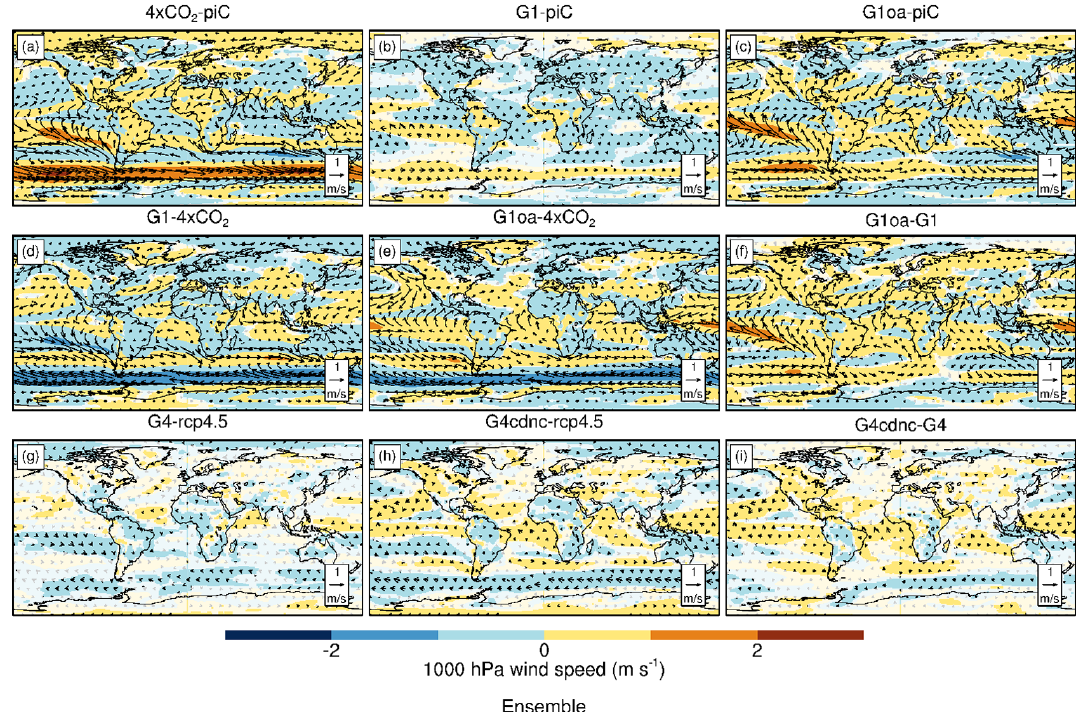
Figure 4. Spatial distribution of six ESMs and ensemble mean 1000hPa wind speed and wind direction (arrows) changes under different scenarios (11–50years). Blue colors indicate decreased wind speed; the length of arrow in each panel’s bottom right represents speeds of 1ms − 1 . Translucent white overlay indicates regions where differences are not significant at the 95% level according to the Wilcoxon signed-rank test.